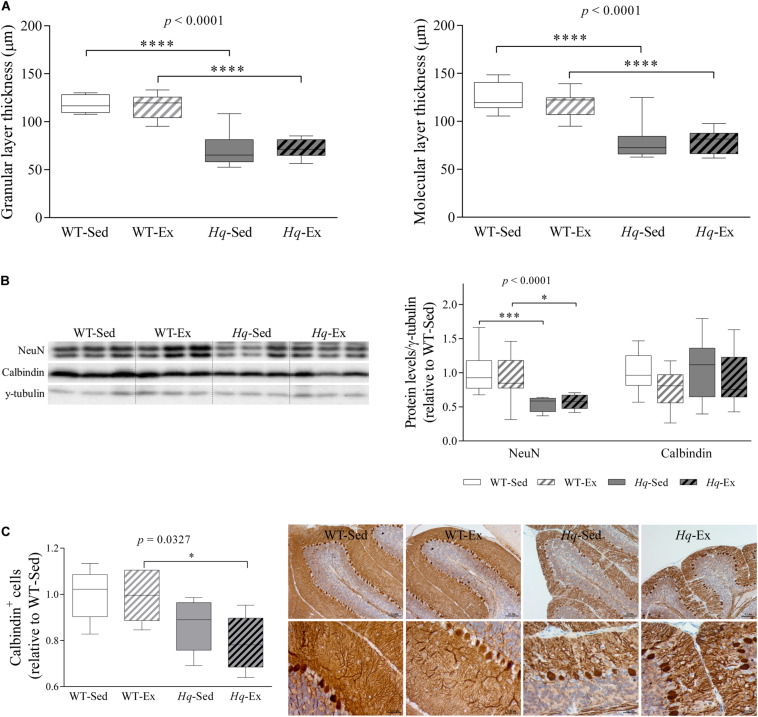
Cerebellar atrophy and neuronal loss. (A) Mean thickness of granular and molecular layers of cerebellar cortex. Analyses were performed in 9 WT-Sed, 8 WT-Ex, 11 Hq-Sed and 9 Hq-Ex animals, using 1 section per mouse. (B) Western blot analysis of NeuN and calbindin in cerebellum homogenates of wild-type sedentary (WT-Sed, n = 12) and exercise-trained (WT-Ex, n = 11) mice, and of Hq sedentary (Hq-Sed, n = 11) and exercise-trained (Hq-Ex, n = 10) mice. Densitometry analysis: protein levels were normalized to γ-tubulin levels; data (median, interquartile range, and min and max values) are expressed relative to levels in the WT-Sed group. (C) Immunohistochemistry analysis of calbindin in sagittal sections of cerebellum of representative WT-Sed, WT-Ex, Hq-Sed and Hq-Ex mice (10× and 40×) and quantitative analysis of calbindin-positive cells (Purkinje neurons) per mm in cerebellar cortex. Significant p-values for the group effect (Kruskal-Wallis test) are shown above the corresponding boxes. Symbols for significant differences in post hoc pairwise comparisons: ∗p < 0.05; ∗∗∗p < 0.001, *⁣*⁣**p < 0.0001 for Hq-Sed vs. WT-Sed, and Hq-Ex vs. WT-Ex. Analyses were performed in 5 animals for each of the four experimental groups, 2–6 images per animal.